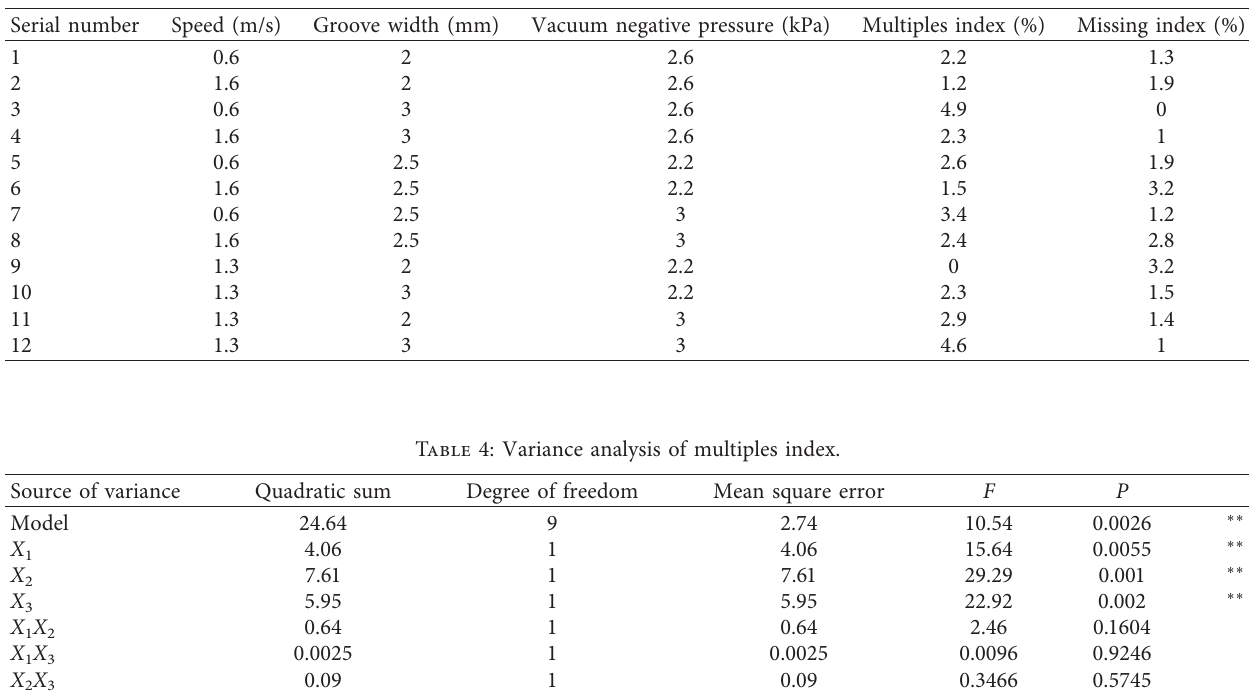
Table 3: Experiment design and response values.